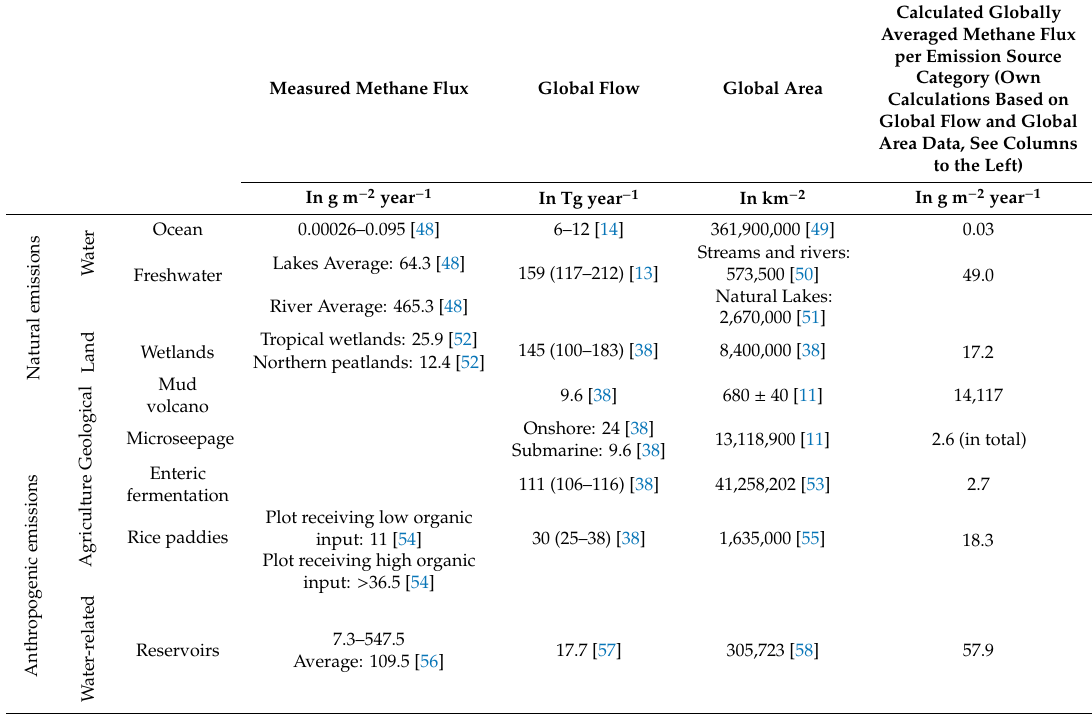
Table 1. Measured and globally averaged fluxes of selected methane sources.